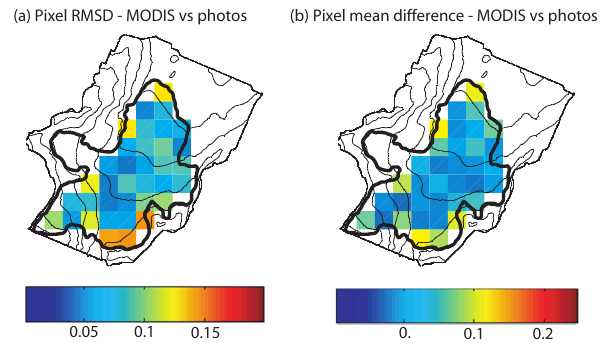
Fig. 3. Comparison between albedo retrieved from MODIS and ter- restrial photographs. (a) RMSD for each pixel of the glacier for 13 epochs over summer 2008 and summer 2009. (b) Mean differ- ence for each pixel for the same 13 epochs. RMSD and difference are indicated in albedo values. The contour of the glacier as it was measured in 2003 is also indicated with the thick black line on the two